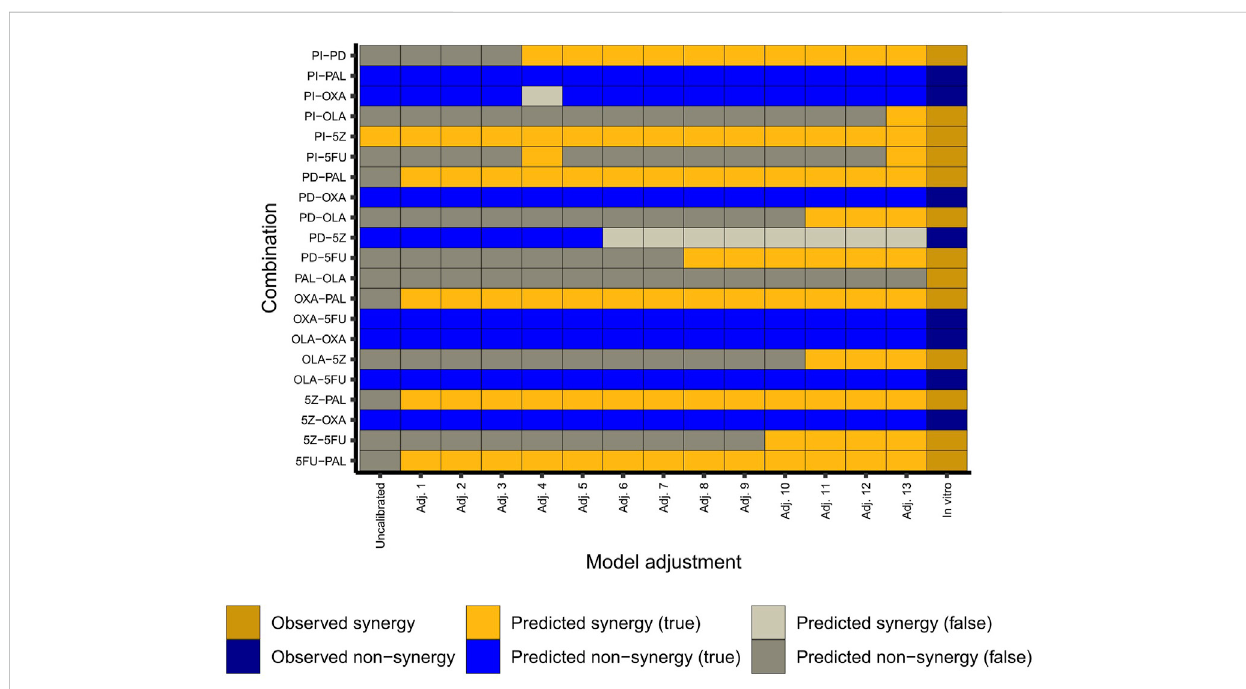
FIGURE 3 Adjustment of the model. The heatmap shows observed ( in vitro in HCT-116 cells) and predicted ( in silico ) combination effects per adjustment step in the conversion of the original model into the fi nal “ HCT-116 adjusted ” model. Adj. 13 corresponds to the adjusted ( fi nal) model. Details of the model adjustments are summarized in Supplementary Table S4 (Supplementary File S1: Results, fi gures, and tables).